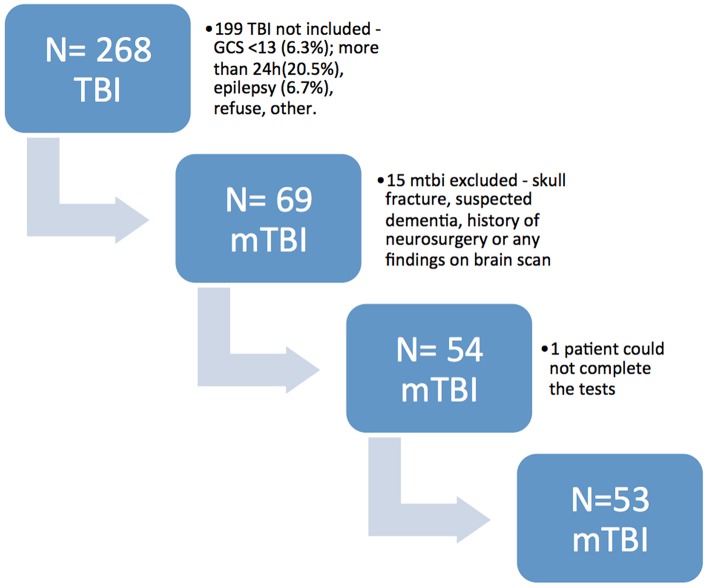
Flow diagram of patient's recruitment. TBI, traumatic brain injury; mTBI, mild traumatic brain injury.